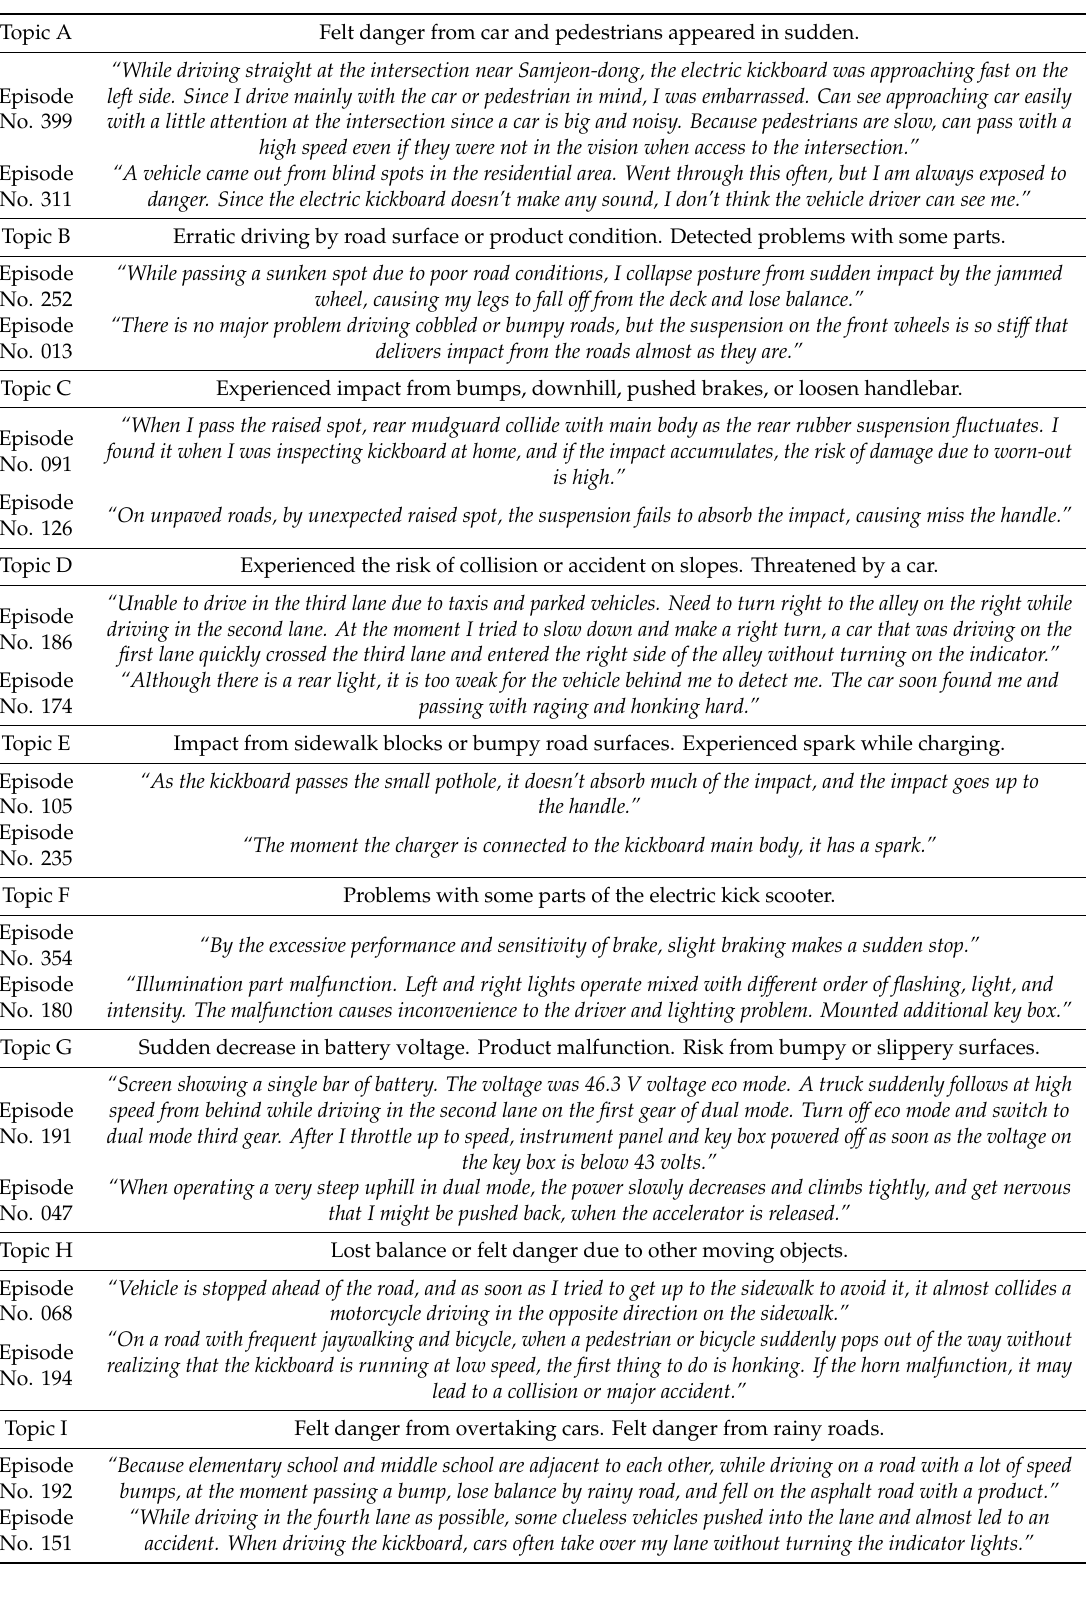
Table A1. Representative episodes of nine topics consisting of electric kick scooter risk